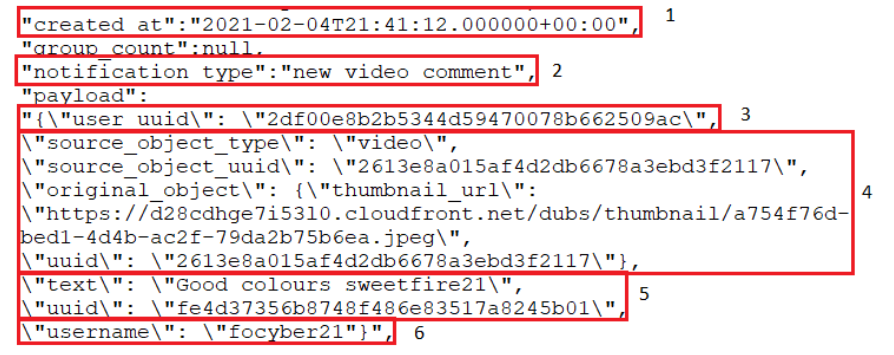
Figure 9. Dubsmash notification generated and shown to the Android user when the iOS user left a